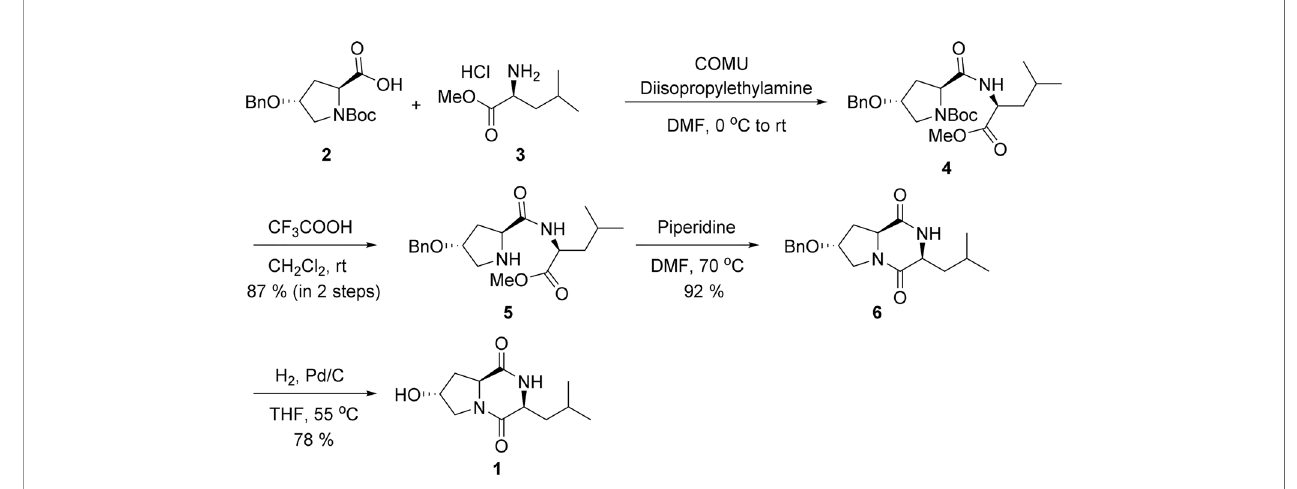
FIGURE 4 | Scheme: Synthetic pathway of cyclo